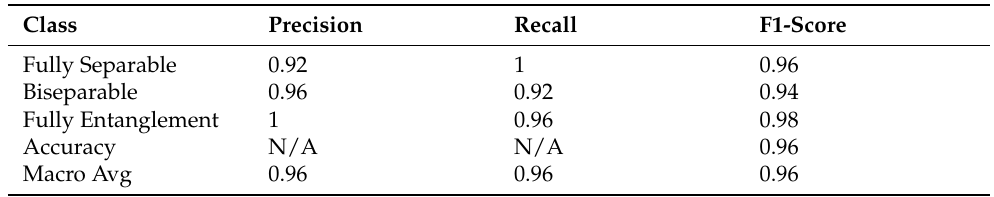
Table 2. Classification report for the Bell-DNN ( 8,3,80 ) model trained with Svetlichny features for mixed tripartite quantum states.